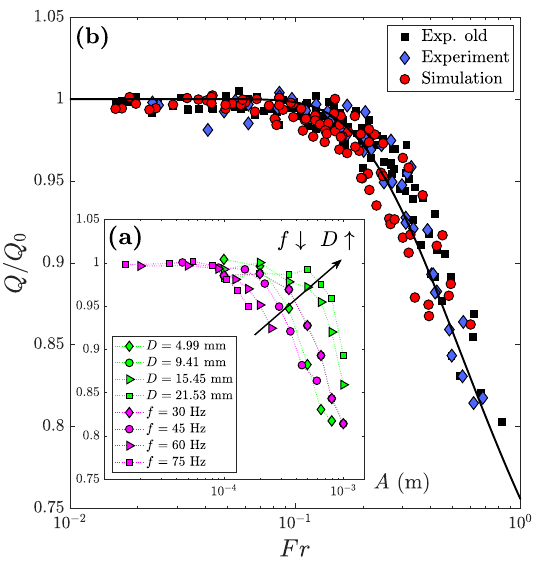
Figure 4. (a) "Instantaneous" relative flow rate Q inst / Q 0 (mea- sured every 10 ms) and v z , silo during the discharge in experiment and simulation. A periodic dynamic is observed in phase with v z , silo : burst of flow rate when the silo goes up (positive peaks of v z , silo ) and nearly no flow when it goes down (negative peaks of v z , silo ). This dynamic comes from the propagation of compression waves in the silo as shown by the profiles of (b) relative vertical velocity v z and (c) volume fraction φ (in simulation, A = 8000 µ